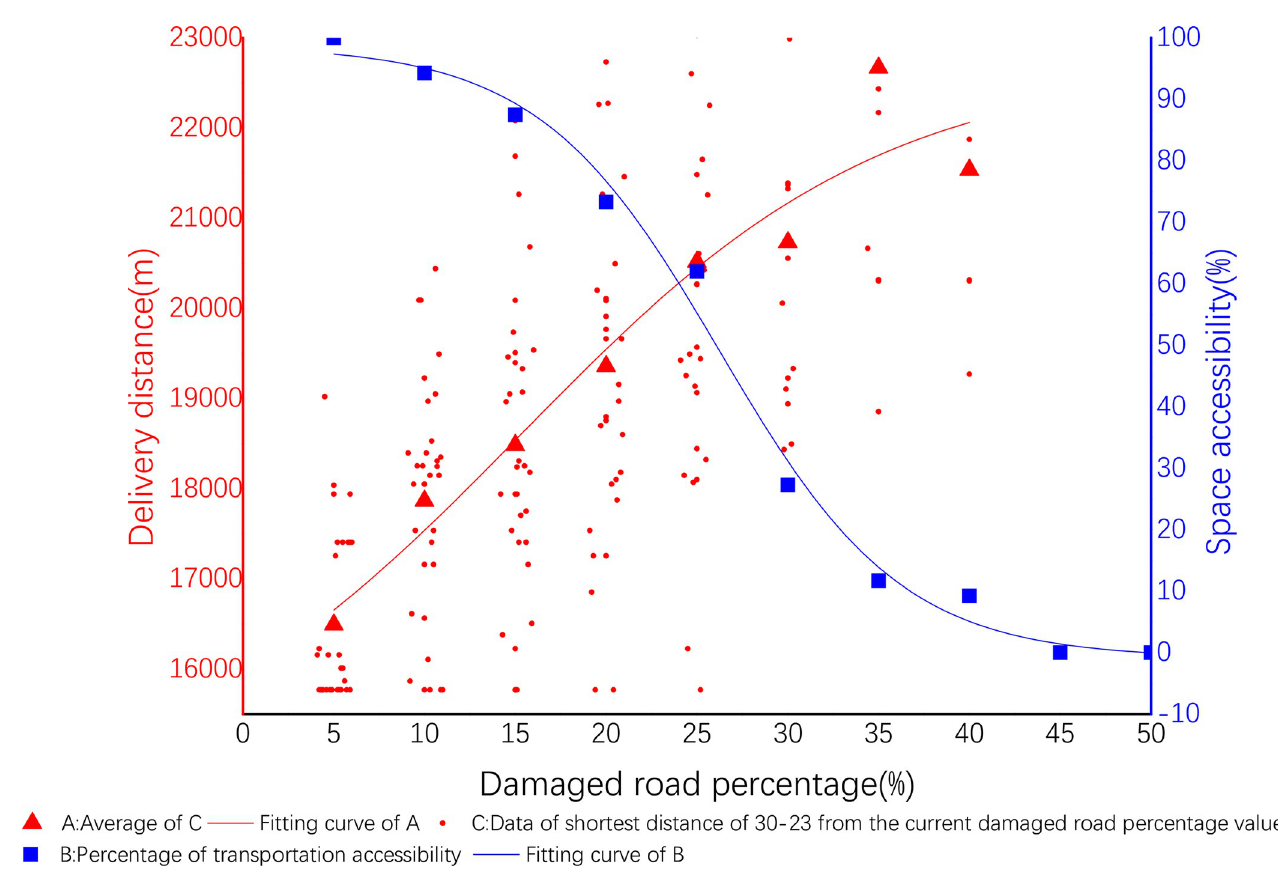
Fig 9. Delivery cost and spatial accessibility of 30–23.